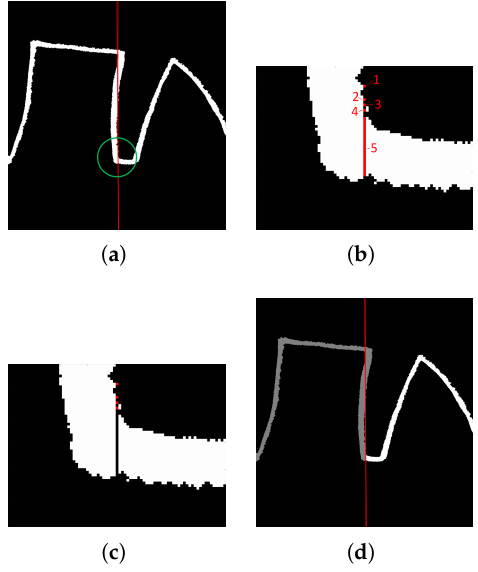
Figure 4. ( a ) Calculated location of separating column. ( b ) Candidate components. ( c ) Separating component no. 5 removed. ( d ) Obtained shapes marked with different